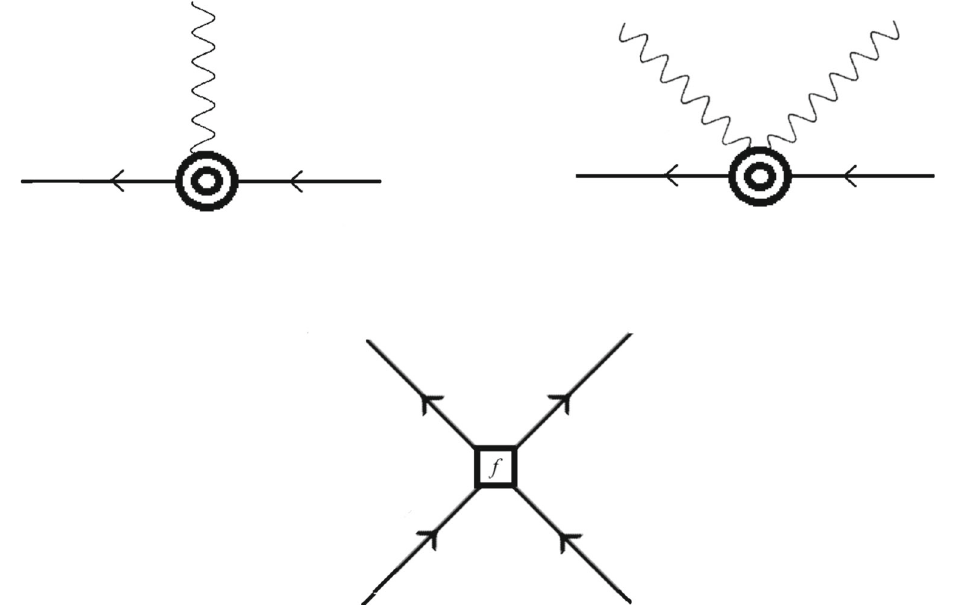
Fig. 1 The new types of vertices. The three legs ones, at difference with the usual thee legs vertices in usual QCD, does not contains lin- ear terms in the gamma matrices. The two-gluon-two-quark four legs vertices are the local counterparts of the non local vertices representing